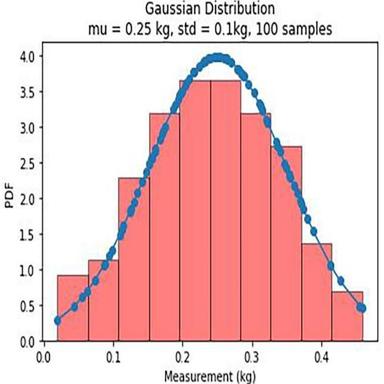
A normal distribution was assumed for the heel left in the crucible. The mean of 0.25 kg and the standard deviation of 0.1 kg were used. The heel amount was modified to verify if the model could maintain the desired false alarm probabilities.